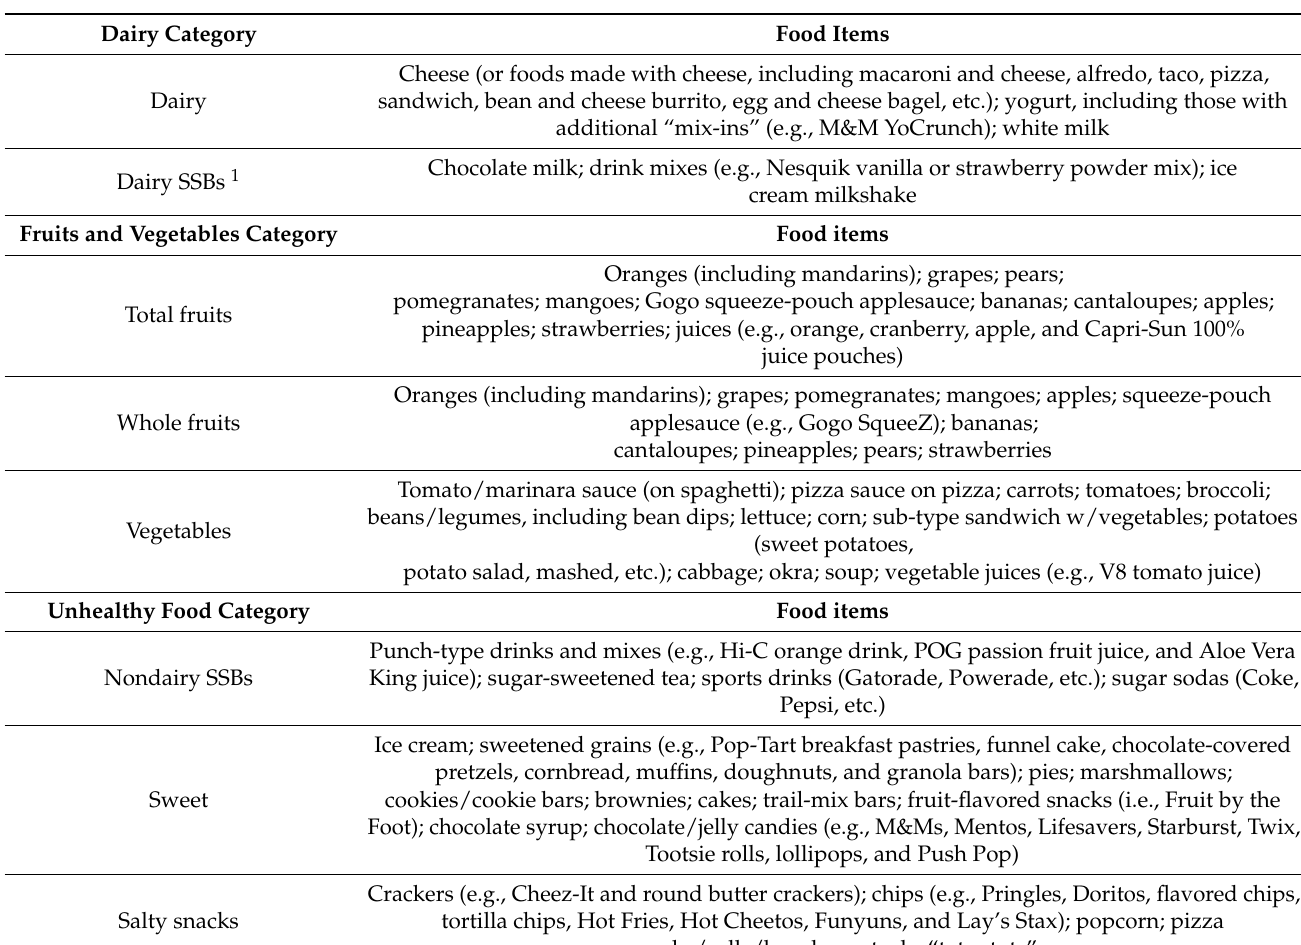
Table 1. Consumed food categories by